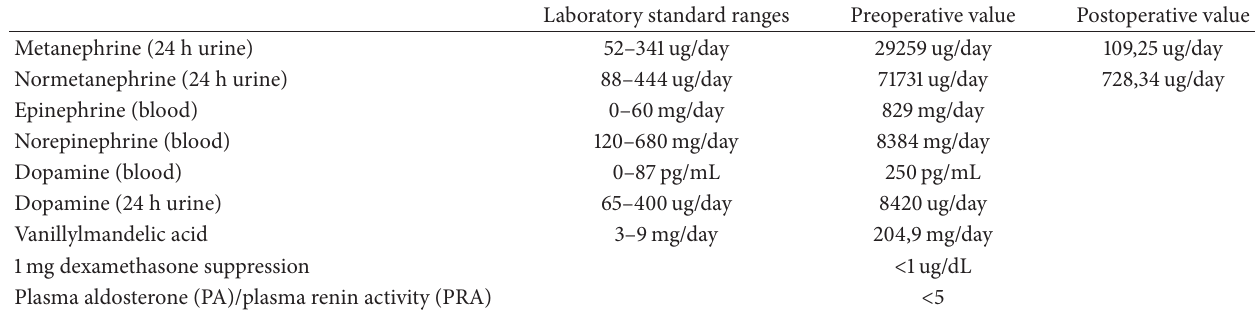
Table 1: The values of some metabolites of our patient.